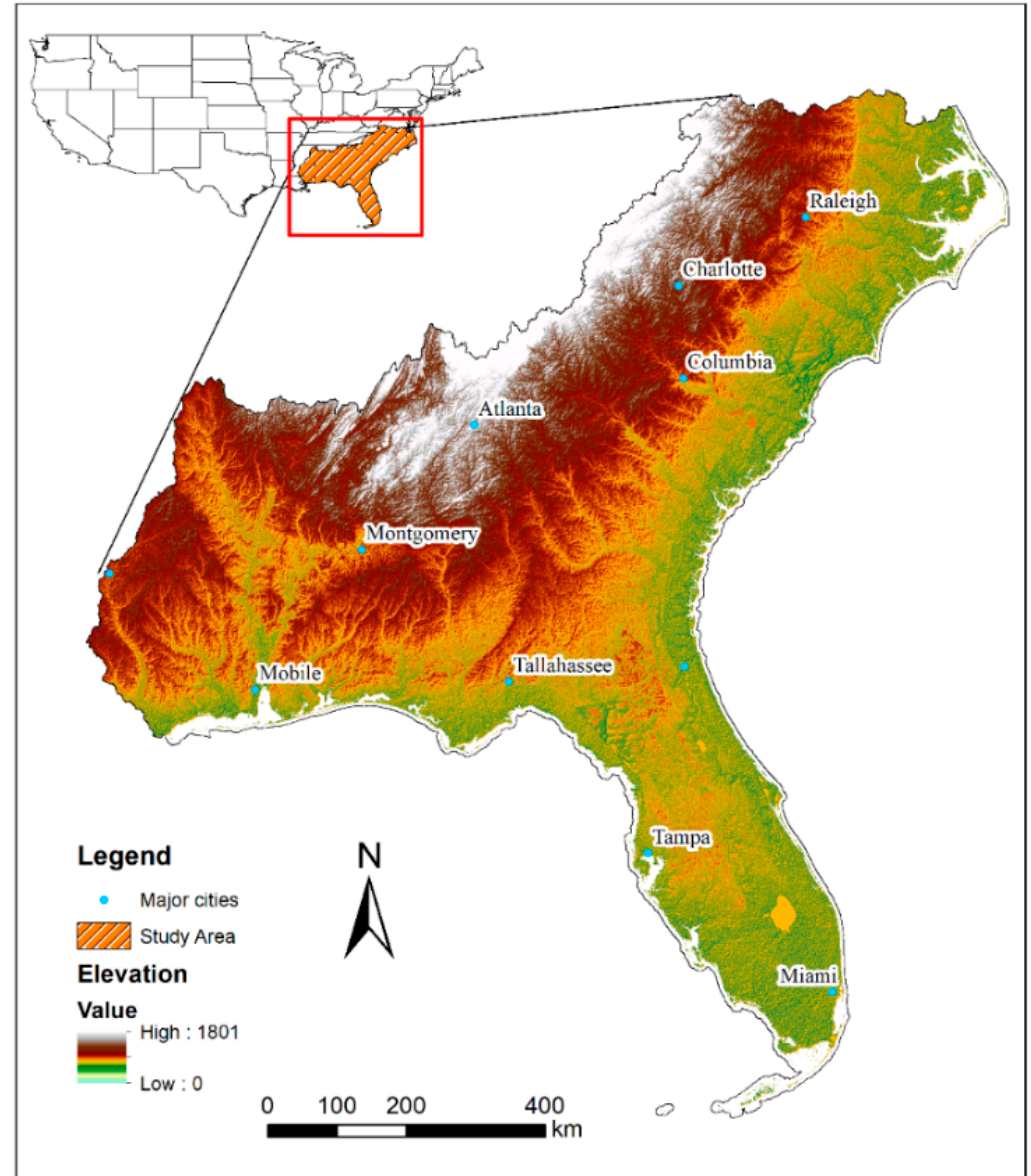
Figure 1. Study area, encompassing the HUC-03 watershed boundary, major cities, and elevation in meters.